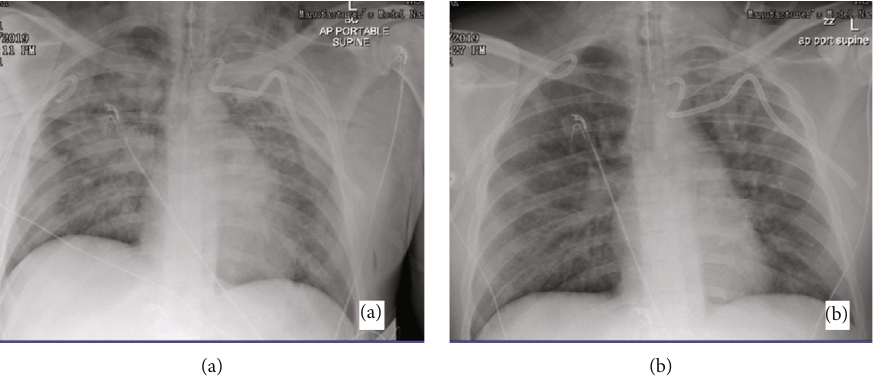
Figure 4: (a) Chest X-ray preprone positioning showing bilateral air space disease with patchy bilateral consolidation from massive spillage of blood from bleeding left bronchial varix and atelectasis. Bilateral pneumothoraxes with placement of bilateral chest tubes. (b) Forty-eight (48) hours post prone positioning with mechanical clot extraction showed interval improvement of airspace